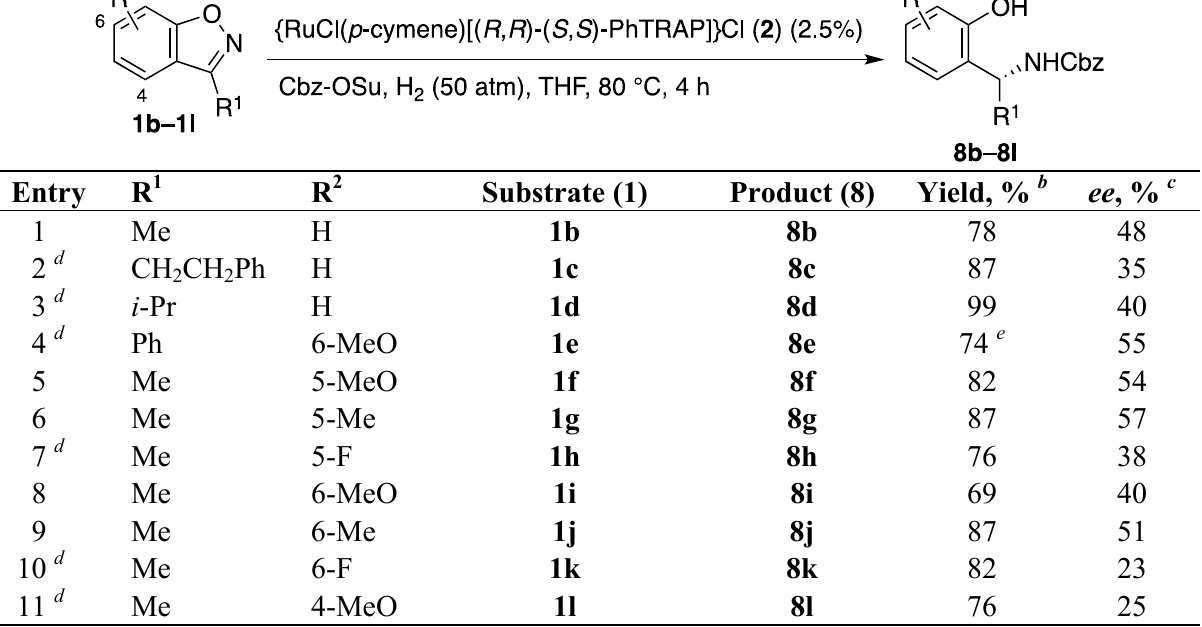
Table 3. Catalytic asymmetric hydrogenation of 3-substituted benzisoxazoles 1 a